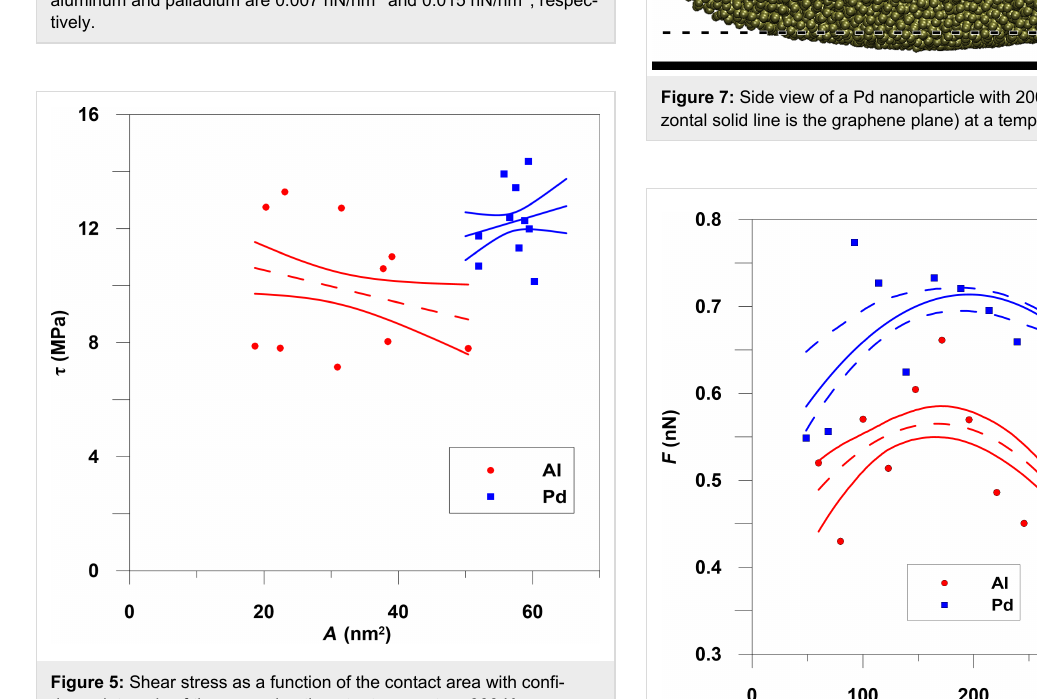
denoted as thermally activated, stress-aided, processes. At low temperature the friction force may decrease with decreasing temperature. This is due to the fact that thermal excitations (thermally excited fluctuations) are necessary in order for the particle to “find” configurations of large binding energy along the sliding path. As a result, at low temperature the interface will become more incommensurate, resulting in an interaction